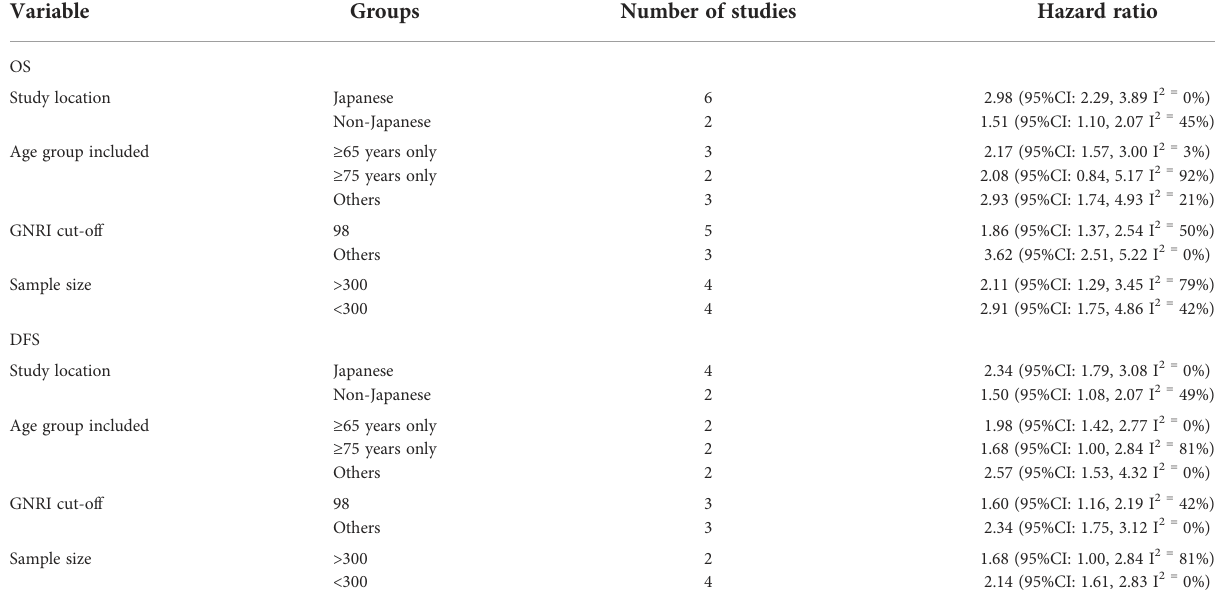
TABLE 2 Subgroup analysis.